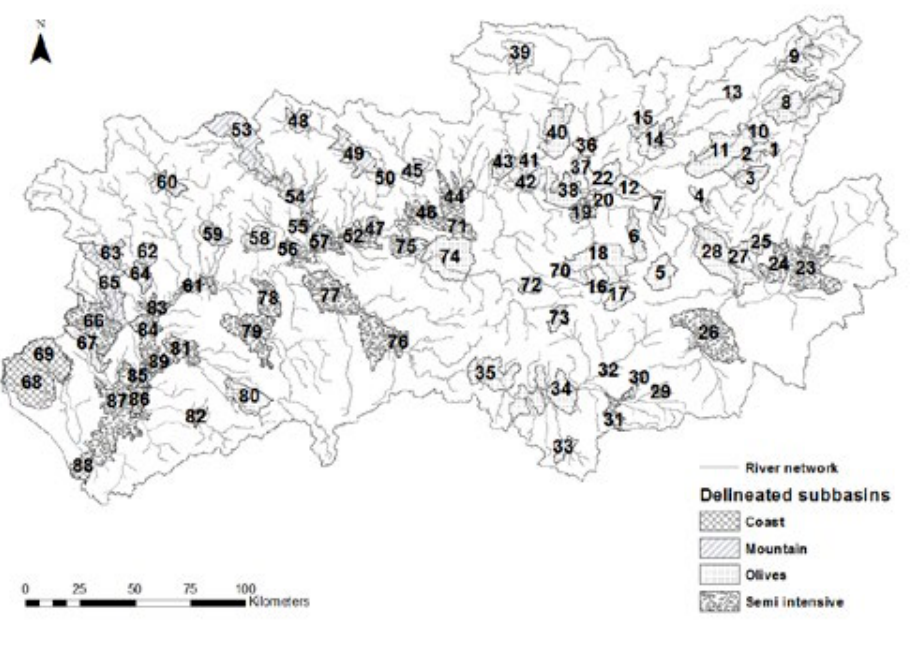
Figure 2. Study subbasins classified by dominant type of agriculture. Source: own elaboration based on monitoring station location (GRBA, 2011), digital elevation model (CNIG, 2011) and main irrigated regions (RGA, 2010a).